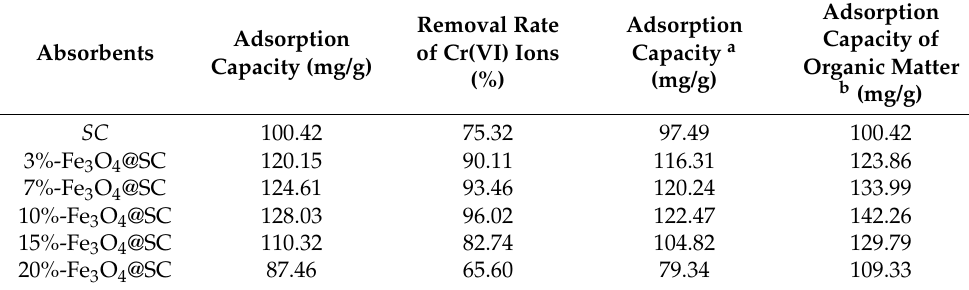
Table 2. The adsorption performance by different